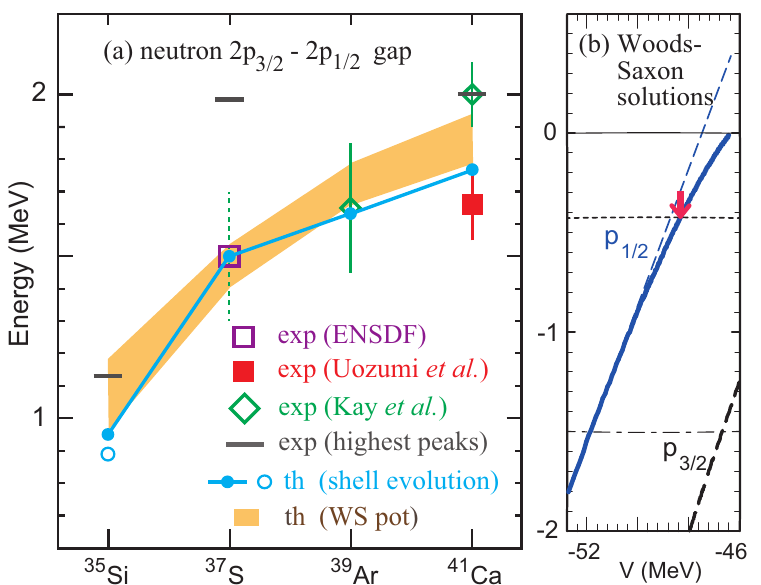
Figure 8. ( a ) Neutron 2 p 3/2 -2 p 1/2 splitting for N = 21 isotones. The symbols are the centroids for 37 S [42], 39 Ar [50], and 41 Ca [50,51]. The horizontal bars are the energy differences between relevant highest peaks [50,52]. Shell evolution predictions are shown by blue closed symbols and the solid line connecting them. The loose binding effect for 35 Si is included in the open circle. The calculation with Woods–Saxon potential with parameters adjusted are shown by the yellowish shaded area [50]. ( b ) Neutron 2 p 1/2 single-particle energy (blue solid line) by a Woods–Saxon potential [12] for varying depth parameter, V. The linear dependence of the deeply bound region is linearly extrapolated (blue dashed line) and is compared to the curved dependence that results from the proximity of the continuum. The dashed line is for the 2 p 3/2 orbit, and the loose-binding contribution to the present splitting appears to be 0.06 MeV against 1.5 MeV splitting itself. Taken from Figure 8 of Supplementary Material of